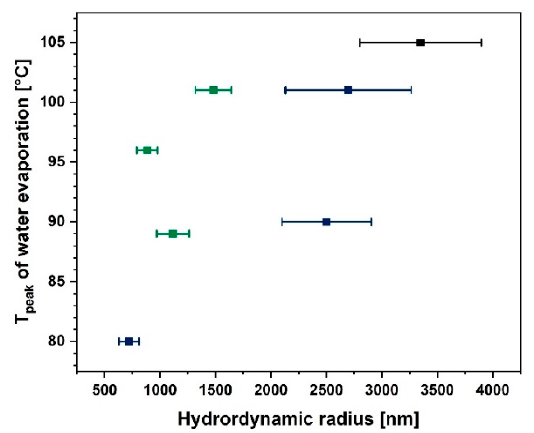
Figure 6. Graph illustrating water evaporation peak temperature as a function of particle hydrodynamic radius.